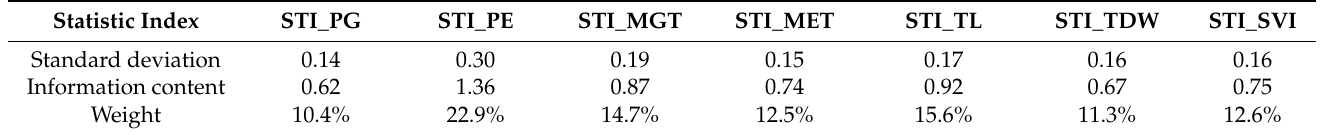
Table 2. Weight of seed germination- and seedling emergence-related low-temperature tolerance indices based on D-CRITIC method. STI_MGT, low-temperature stress tolerance index of mean